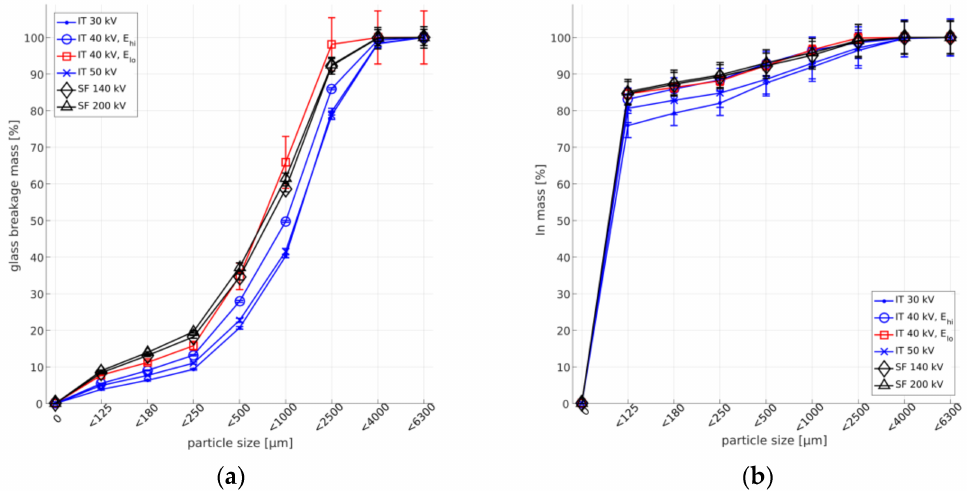
Figure 5. Cumulative particle size distribution of: ( a ) Glass breakage from filtration and sieve analysis; ( b ) Mass of indium detected within glass breakage from filtration and sieve analysis.